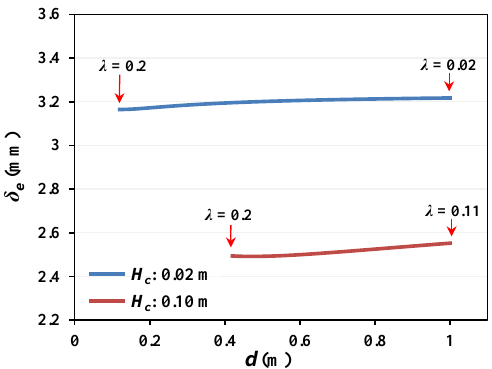
Figure A1. Variation of effective boundary layer thickness with disc diameter ( d ) for different disc heights ( H c ) at wind speed of 1ms − 1 and surface coverage of 0.91 (dense packing). The increase in λ to more than 0.2 forms a relatively thick boundary layer on the order of disc height. For U = 1ms − 1 , the boundary layer thickness over the uncovered surface is calculated as 3.2mm based on Haghighi and Or